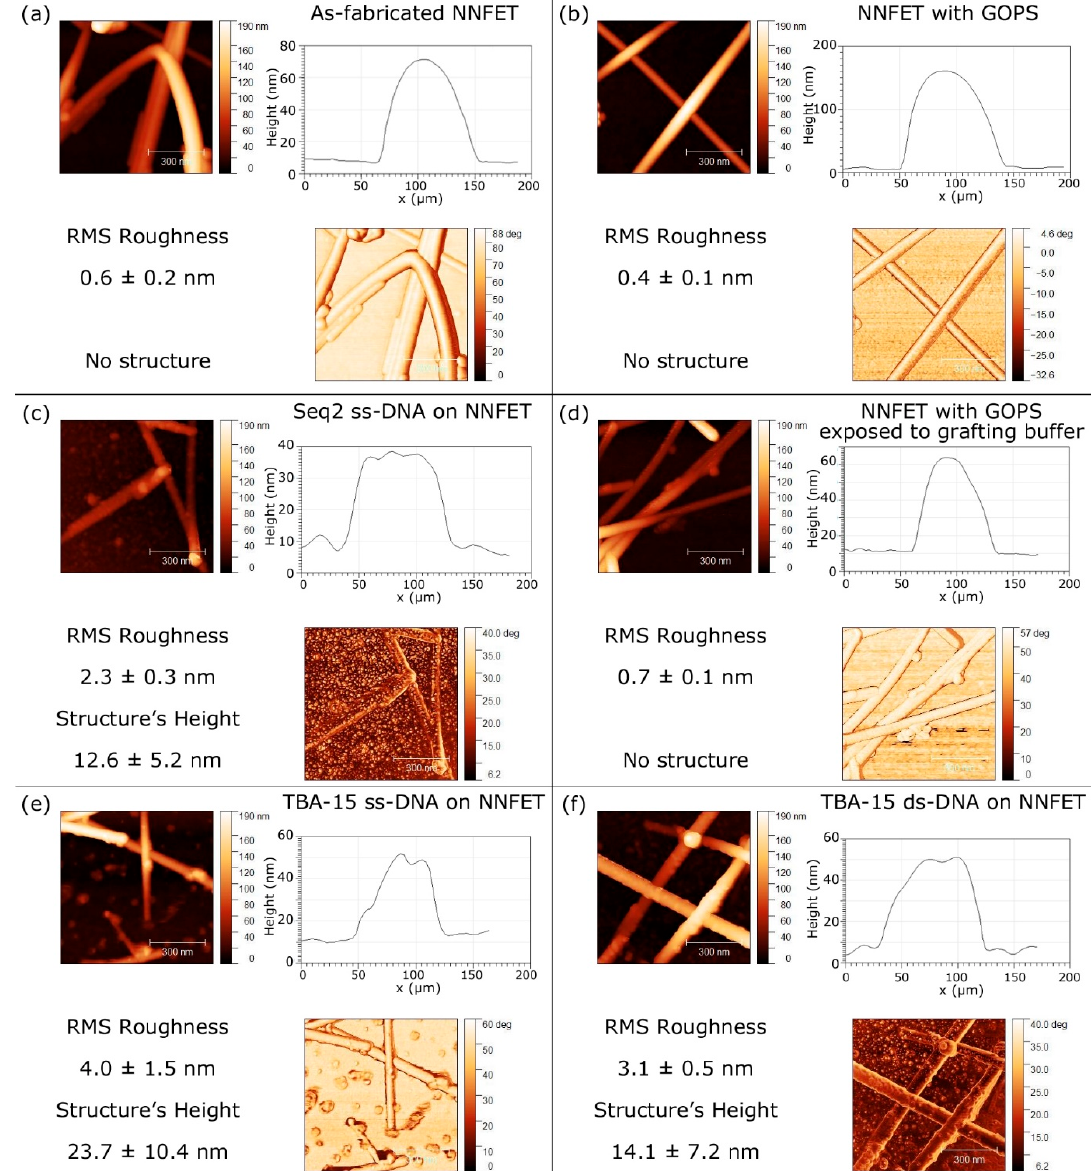
Figure 5. AFM analyses on Al 2 O 3 -passivated Si nanonet FETs at different steps of functionalization. ( a ) Bare Al 2 O 3 passivated NN–FET. ( b ) After GOPS silanization. ( c ) After Sequence 2 probe grafting. ( d ) After GOPS silanization and exposition to the grafting phosphate buffer (without DNA probe). ( e ) After TBA–15 probe grafting. ( f ) After TBA–15 hybridization with complementary DNA (cTBA target).